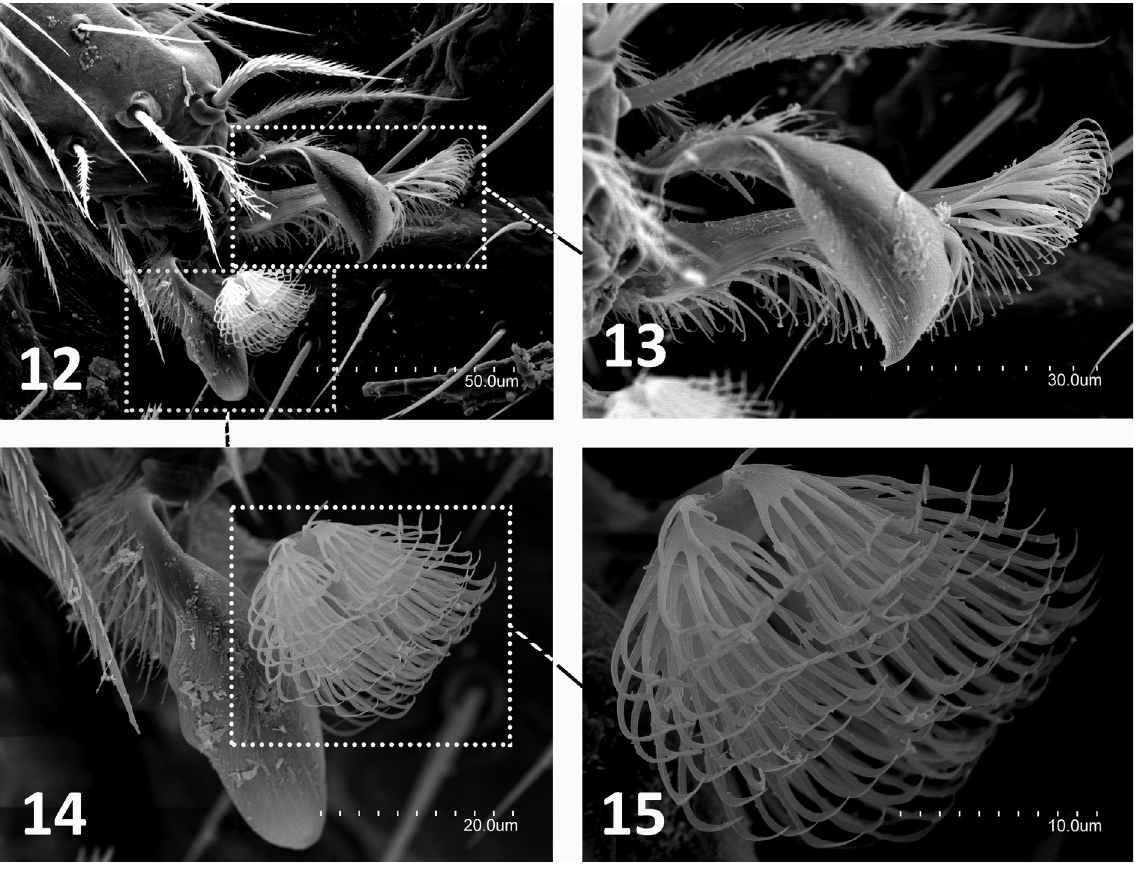
Figs 12‒15. Anisuracampa ywangana Sendra & Komerički sp. nov. 12 . Pretarsus of metathoracic leg. 13 . Posterior claw and its lateral processes of pretarsus. 14 . Anterior claw and its lateral processes. 15 . Detail of lateral